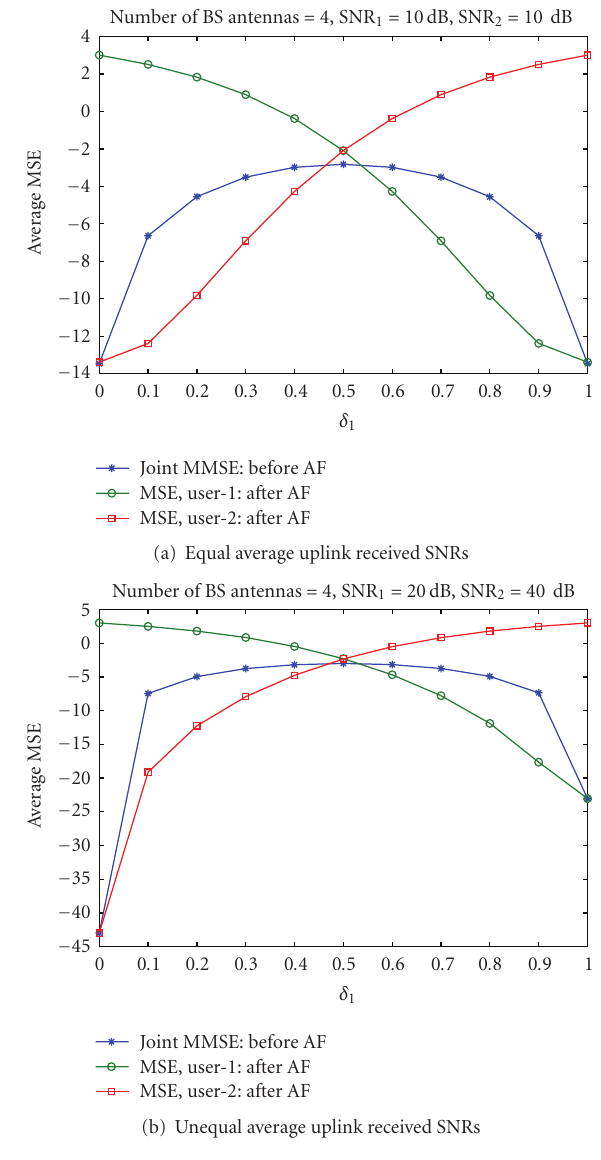
Figure 4: Average MSE of MMSE-BAF system with 4 antennas at the